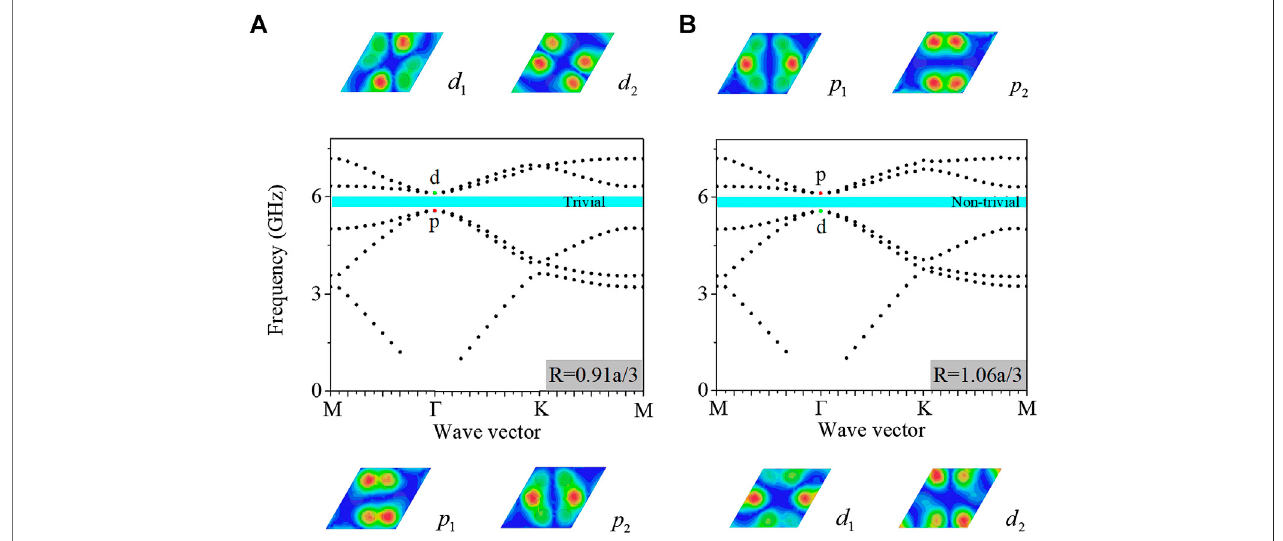
FIGURE 2 | Band structure for different R . The band gap is opened at the Γ point as R varies. (A) As R (cid:4) 0 . 91 a / 3 ( R < a / 3 ) , band gap is topologically trivial. d -type modes areatthehigher frequencyand p -type modesareat thelowerfrequency,whichtheelectric fi elddistributionsareshown intheupper andlowerillustrationsofthe band structure diagram, respectively. (B) As R (cid:4) 1 . 06 a / 3( R > a / 3), the band gap is topologically non-trivial. The p -type modes and d -type modes are